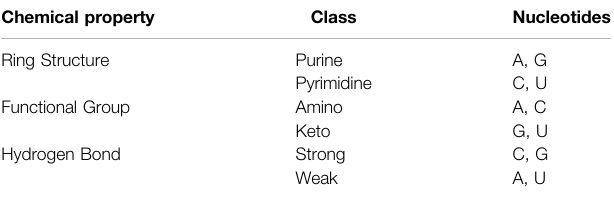
TABLE 2 | Chemical structure of each nucleotide. Chemical